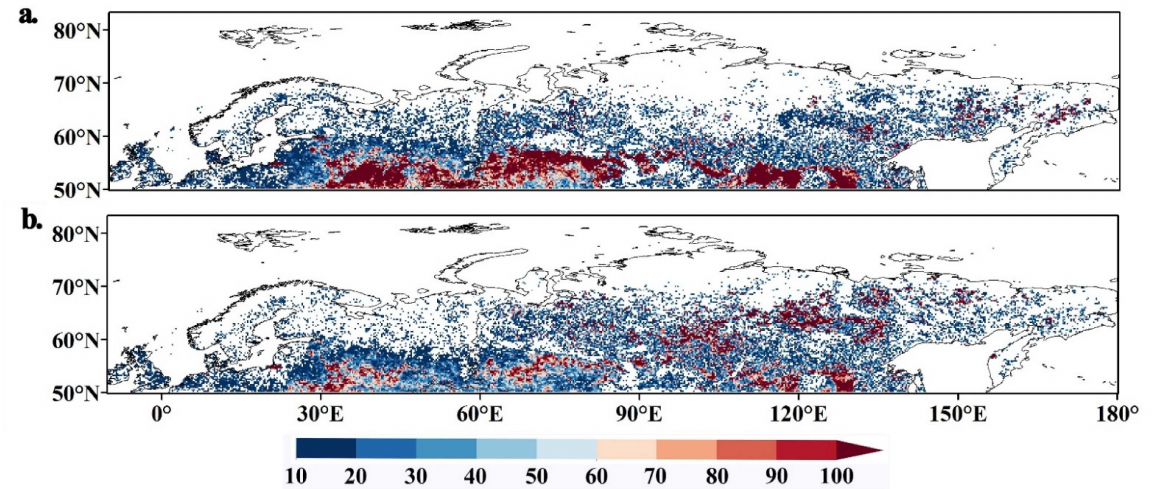
Figure 5. Multi-year mean active fire counts in NEA for 2003–2011 (P1) and 2012–2020 (P2). Panel ( a ) and ( b ) show the spatial patterns of multi-year mean fire count in NEA during the two epochs. Overall, the active fire counts decreased by ~16% to 9.42(±2.55) × 10 5 during the past two decades. However, the inter-decadal changes in wildfire counts contained considerable